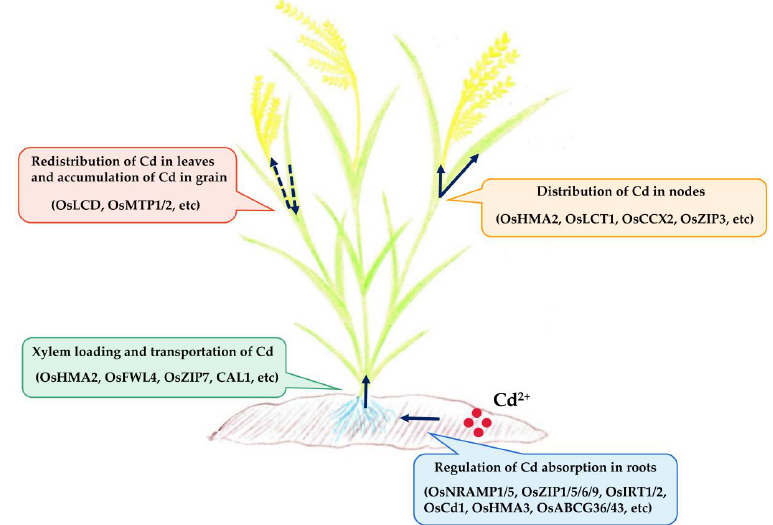
Figure 1. Schematic diagram of the Cd accumulation in